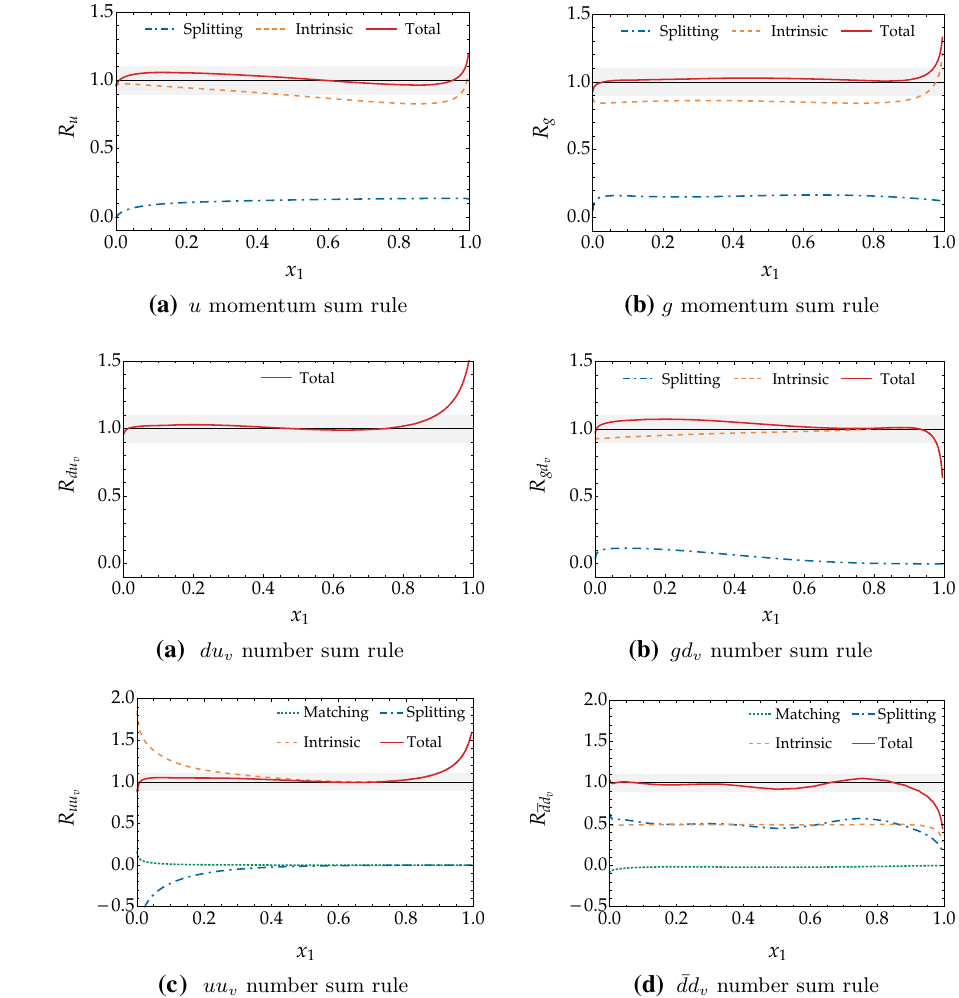
Fig. 13 Momentum sum rule ratios R u and R g for the final iteration of our model. The corresponding plots for the initial model are in Fig. 1 and those for the first iteration in Fig. 4. Not shown is the separate contribution from the matching term F match , which is negligible in this case